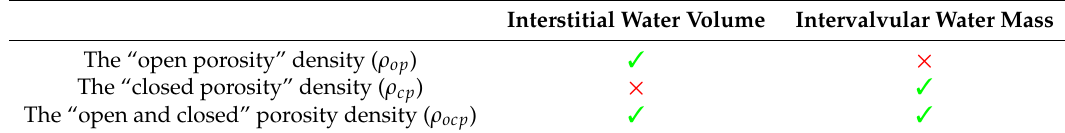
Table 3. Definition of three different densities depending on interstitial and intervalvular